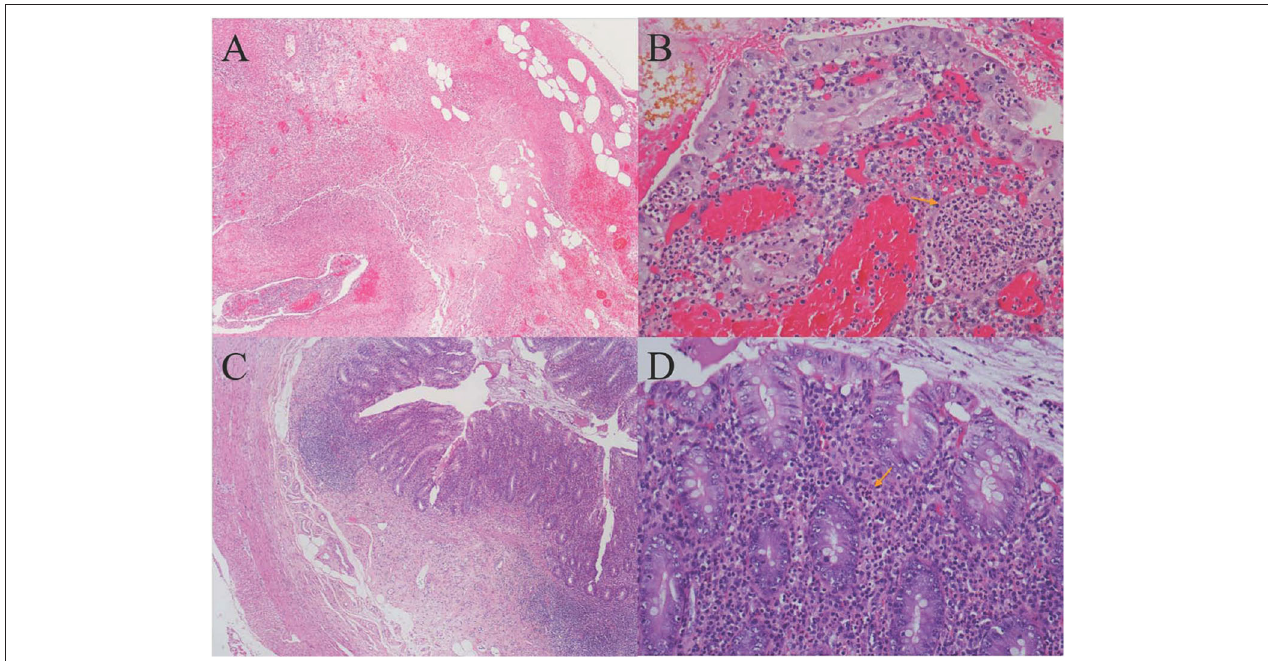
FIGURE 2 | (A) Histology of gallbladder tissue (hematoxylin-eosin stain, magnification × 40); (B) Histology of gallbladder tissue (hematoxylin-eosin stain, magnification × 200): Extensive transmural infiltration of neutrophils and mononuclear inflammatory cells with intramural abscess formation (yellow arrow) indicating full-thickness necrosis, which contributed to the pathological diagnosis of severe acute gangrenous cholecystitis. (C) Histology of appendix tissue (hematoxylin-eosin stain, magnification × 40): The infiltration of both lymphocytes and plasma cells in the appendix wall, accompanied by hyperplasia of fibrous and adipose tissue in the submucosa, revealing chronic inflammatory changes of appendix. (D) Histology of appendix tissue (hematoxylin-eosin stain, magnification × 200): The focal inflammatory cell infiltration of neutrophils in the submucosa (yellow arrow) revealed focal acute changes of